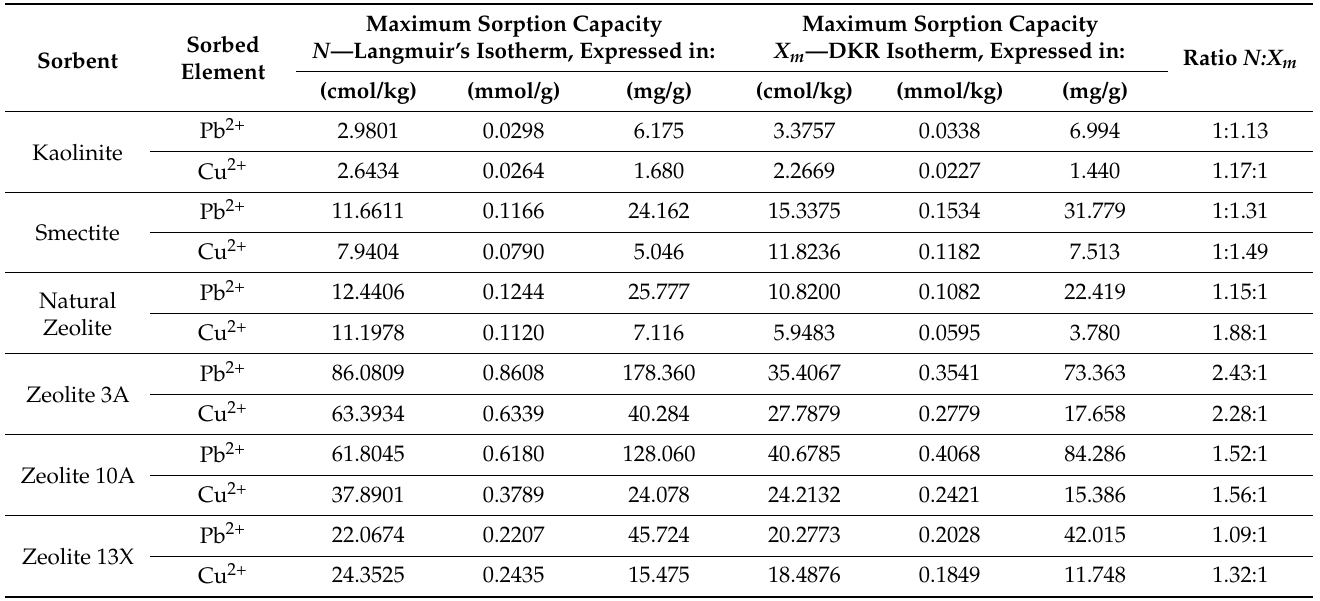
Table 7. The values of maximum sorption capacity in Langmuir’s ( N) and DKR ( X m ) isotherms and their